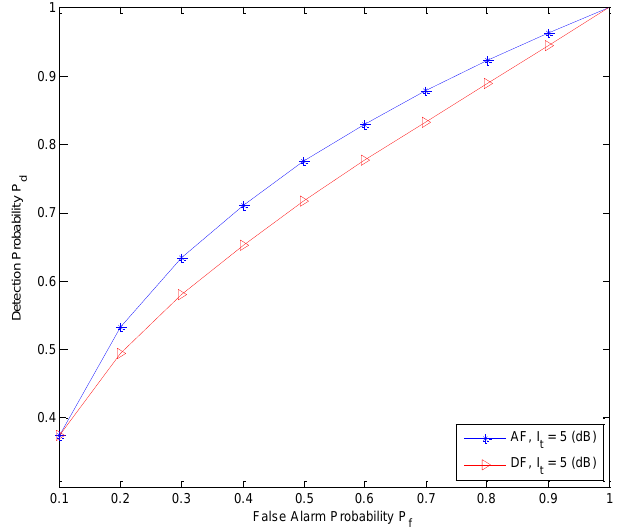
Figure 7. Comparison of the ROC ( P vs. P ) of the secondary user S between DF-CSS and d f AF-CSS (P = 3 dB, P = 0 D-Rx S-Rx